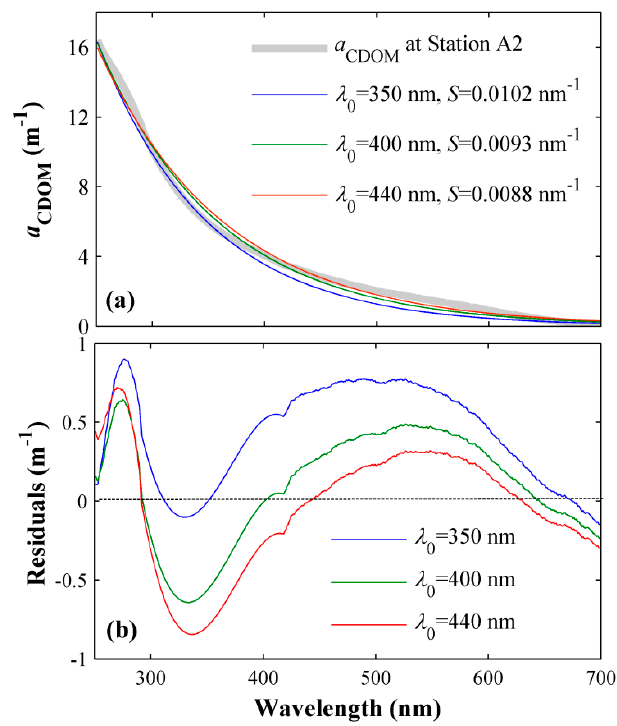
Figure 1. In situ absorption spectrum measured in the Pearl River Estuary in May 2014 (thick gray line) and the exponential curves (colored lines) fitted to Equation (1). The fits were obtained over the same wavelength range (250–700 nm) but with a different reference wavelength ( λ 0 ), resulting in various spectral slope ( S ) values (see legend in ( a )) and various residuals (see colored lines in ( b )). The absorption spectrum sampled at the surface of Station A2 is used as an example (please refer to [29] for detailed information on Station A2).